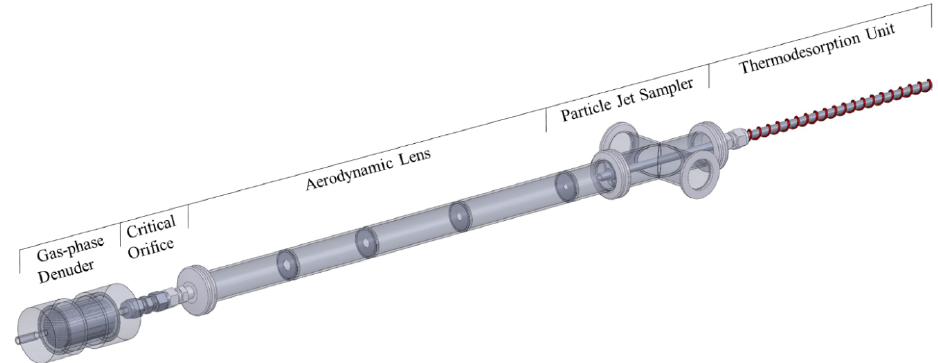
Figure 1. The CHARON inlet with its main components including (i) a gas-phase denuder, (ii) a critical orifice combined with an aerody- namic lens and an inertial sampler for the particle-enriched flow and (iii) a thermodesorption